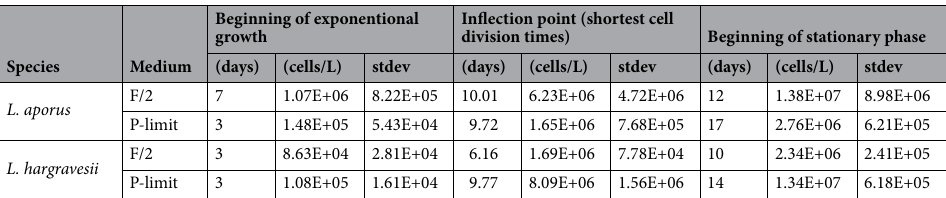
Table 1. Growth dynamics of L. aporus and L. hargravesii shown by cells/L on various days.